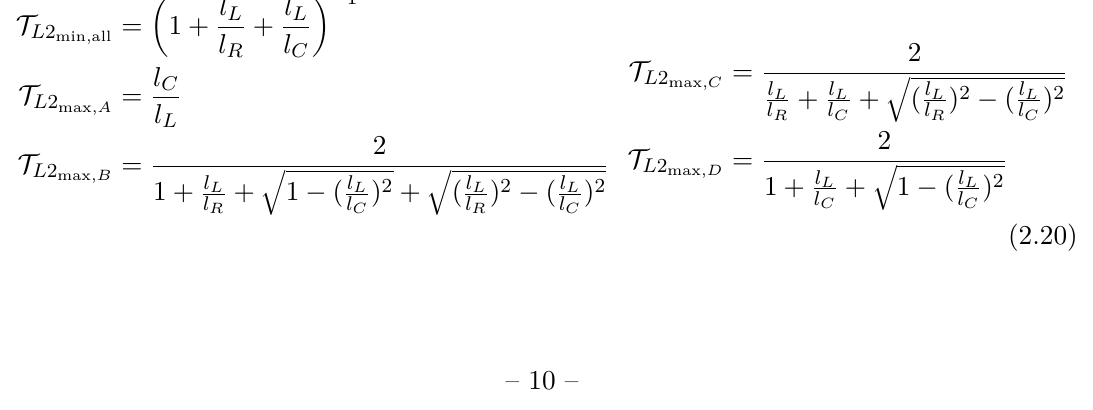
Figure 3 . Transmission coefficient for the 3-region holographic model where we consider a symmetric fusion of defects l L = l R and τ 1 = τ 2 , where l L /l C ranges from 0 . 05 to 20 . coefficient values as one goes from the 2-region to the 3-region model. The lower and upper bounds for the transmission coefficient can be obtained by using the upper and lower limits of tensions respectively. T ’s upper bound would differ depending on how the AdS radii L 2